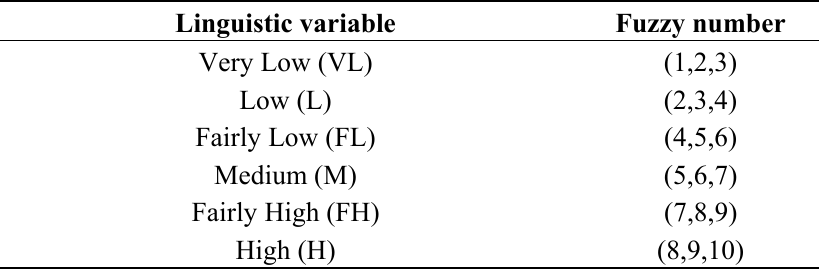
Table 1. Linguistic terms and corresponding fuzzy